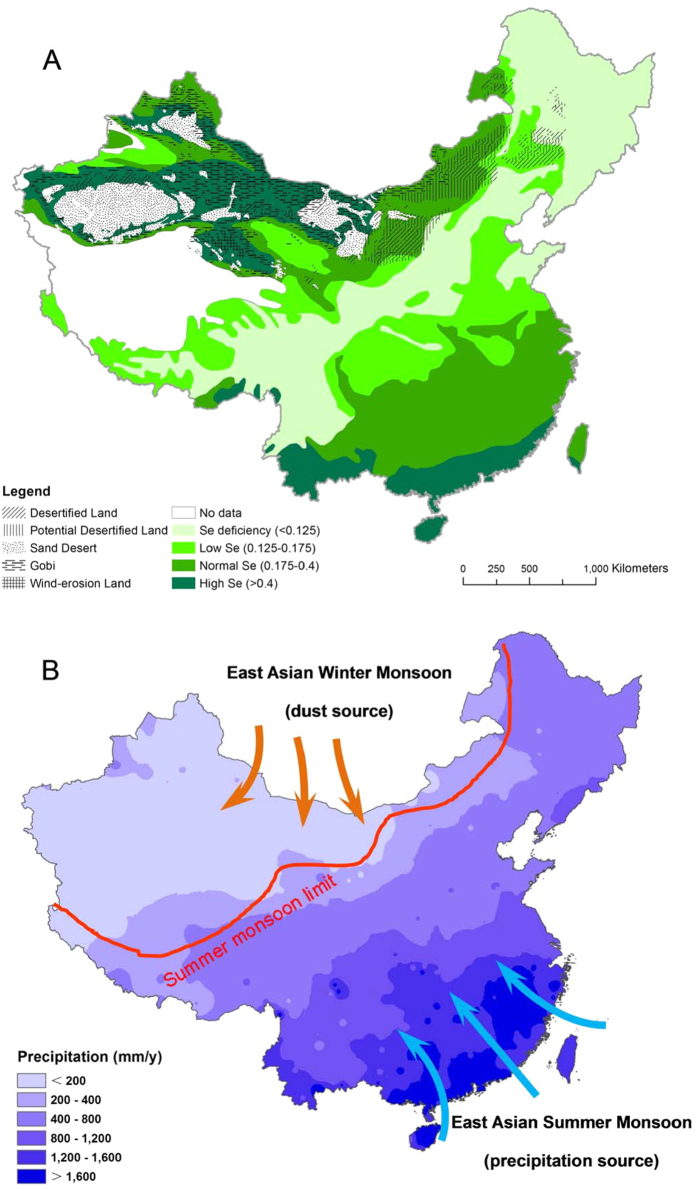
Distribution pattern of soil selenium concentration and desert (A), and wet deposition (B) in China (China Meteorological Data Sharing Service System, China’s precipitation data of 1971–2000. http://cdc.nmic.cn/home.do). The maps were created using Arc GIS Geographic Information Systems software version 10.2 (Environmental Systems Research Institute Inc, Redlands, Calif).